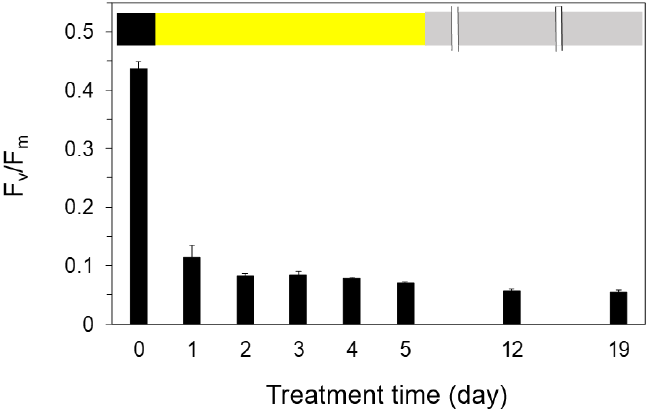
Figure 6. Effect of cumulative diurnal light–dark cycles on F v /F m at 2 ◦ C. The exposure of the filamentous cells to sine-like modulated light (maximal PPFD of 500 µ mol m − 2 s − 1 at 6 h from the onset of the illumination) for 12 h with the dark for 12 h was repeated for the first 5 days (yellow bar). After then, the mild modulated light (maximal PPFD of at 250 µ mol m − 2 s − 1 at 6 h from the onset of the illumination) for 12 h with the dark for 12 h was repeated for 14 days (gray bar). Measurements were taken in the cold room (40 Pa CO 2 , 21 kPa O 2 , at 4 ◦ C). The values represent the means ± SD ( n = 3–6).